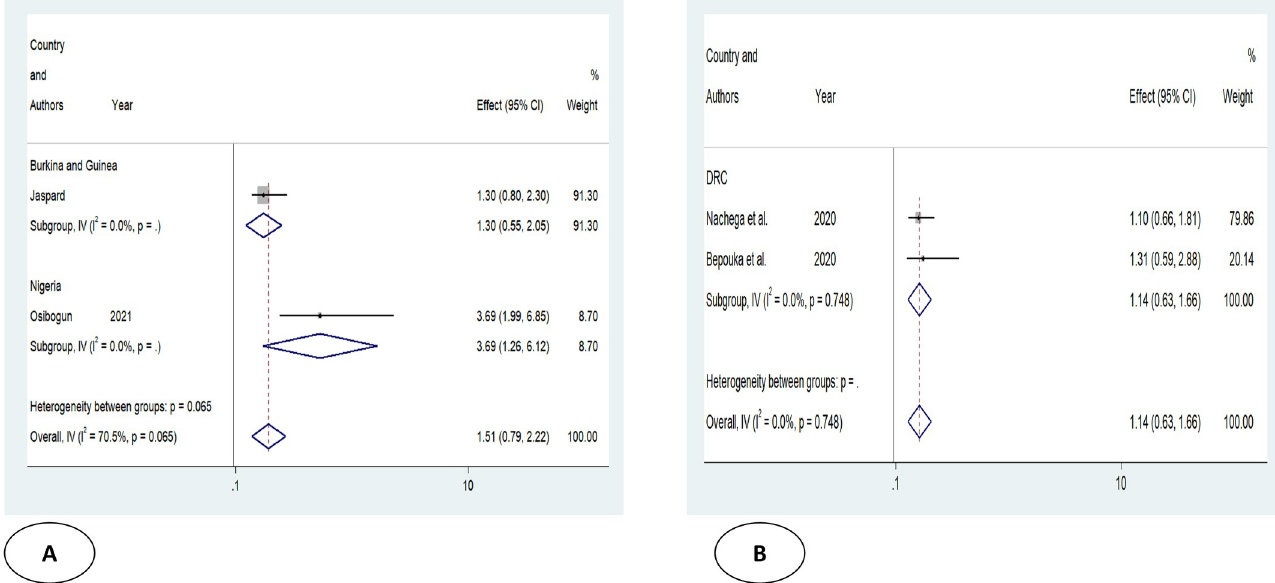
Fig 6. Forest plot showing the estimate for the effects of DM on COVID-19 mortality. Forest plots of studies using A. Odds ratio, B. Hazard ratio.